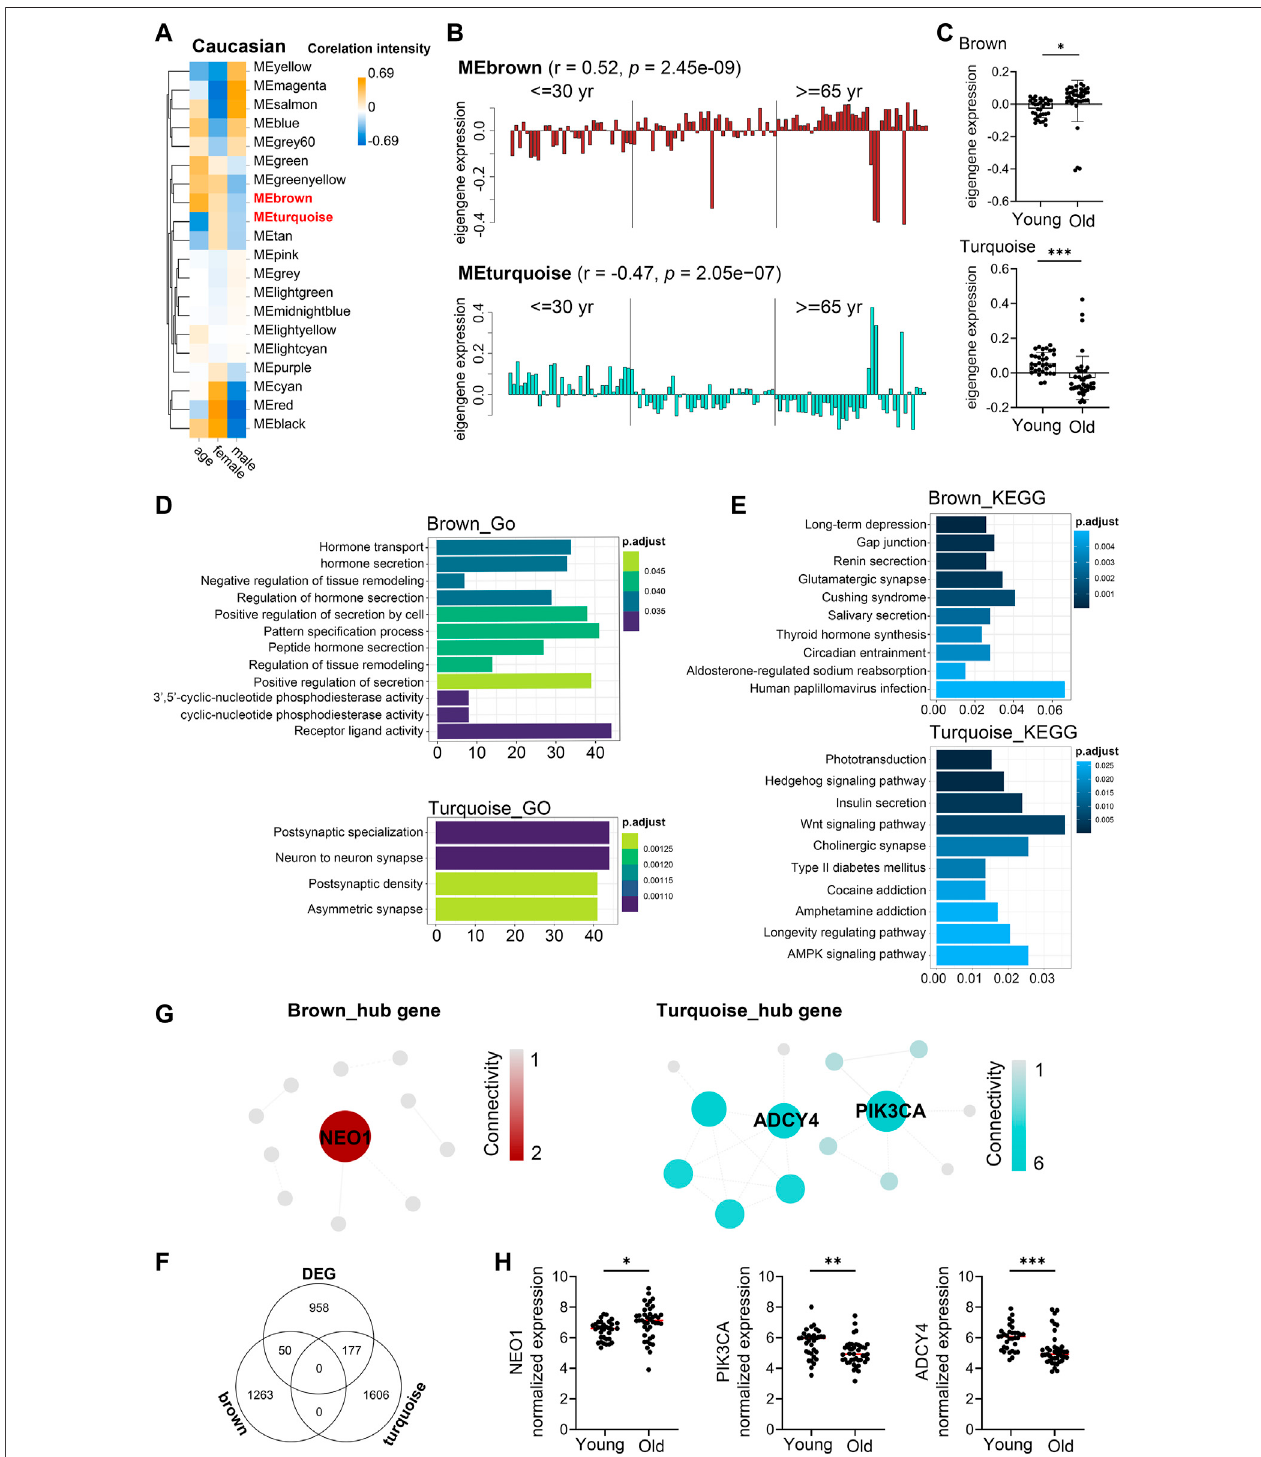
FIGURE 5 | Aging-related changes in PBMC transcriptomes in Caucasian and its hub gene detection. Transcriptome data of 113 healthy Caucasian subjects in 10KIPwereanalyzedandgenemoduleswereconstructedbyWGCNA. (A) Module-traitrelationships.Rowandcolumncorrespondedtomoduleeigengenesandclinical trait (age and gender), respectively. Each cell contained the corresponding Pearson ’ s correlation coef fi cient and p -value. (B) The histograms presentation of the eigengene expression in the brown and turquoise modules from young to old. (C) Comparison of eigengene expression of the brown and turquoise modules between young and older. The transcriptomic expression of age related modules changed signi fi cantly among young and old individuals. Box plots represent